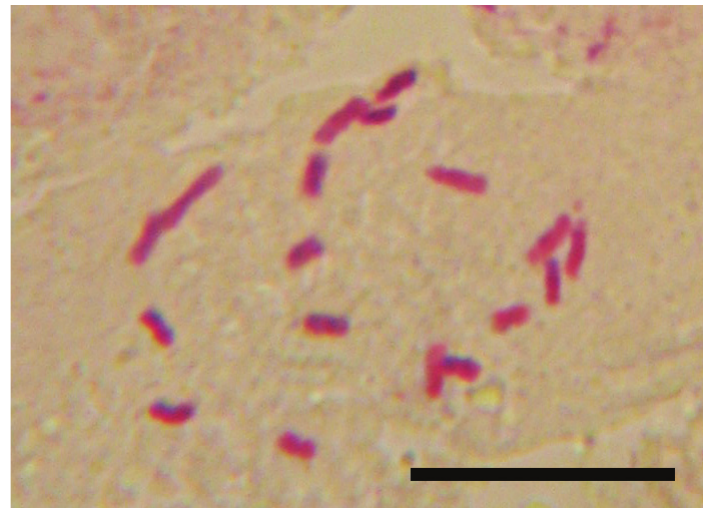
Figure 5. Centaurea sarfattiana Brullo, Gangale & Uzunov, 2 n = 18. Scale bar: 10 μm.